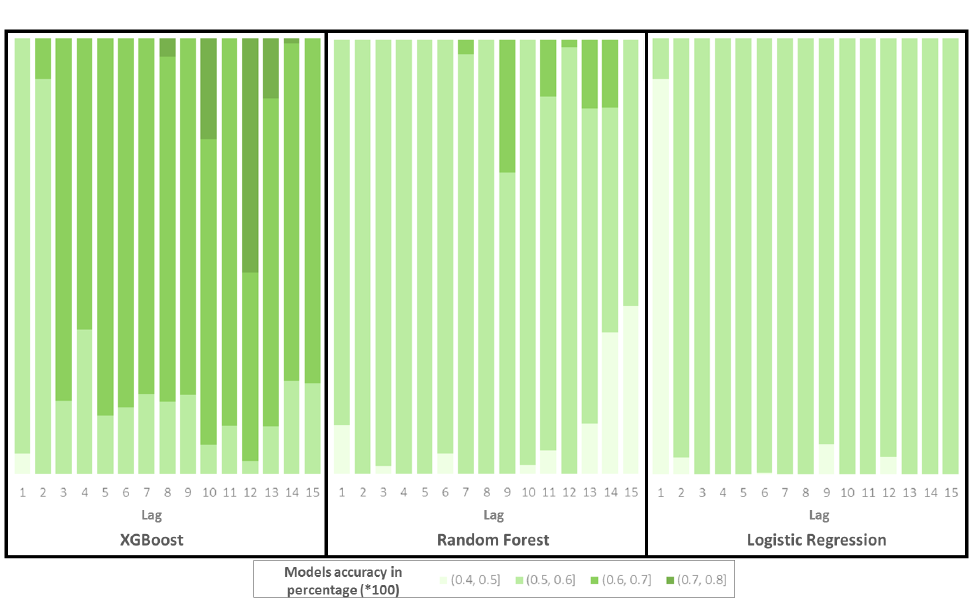
Figure 5. Lag comparison over 15 days and overall Machine Learning models